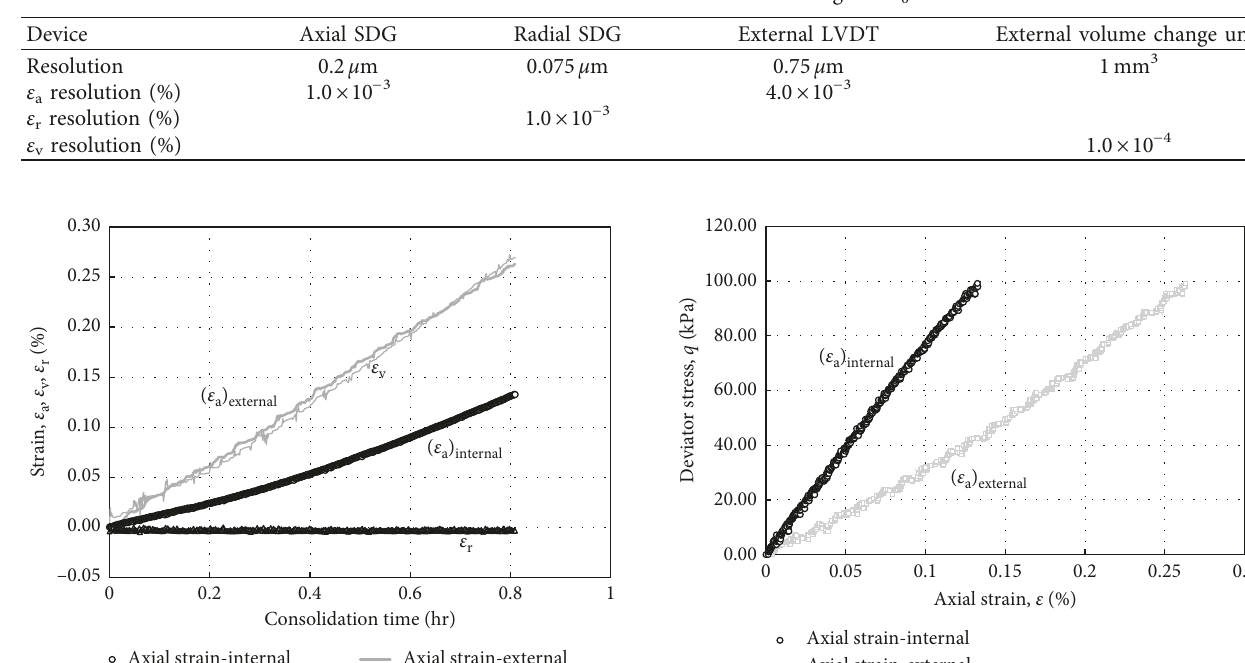
Table 5: Resolution of the various devices used during the K